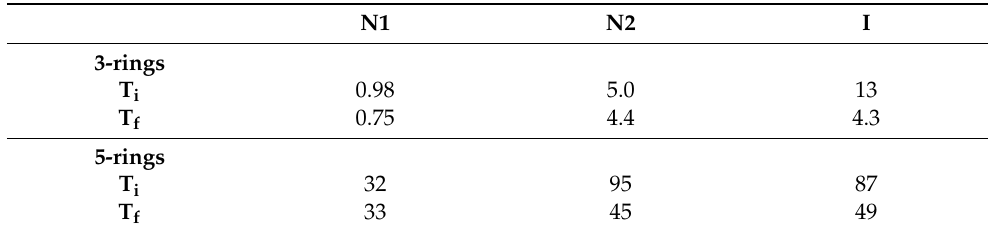
Table 4. Mean degradation (% of the T b initial values) of 3- and 5-rings PAHs in each soil system (N1, N2, I) and at each sampling time (T i , T f ).